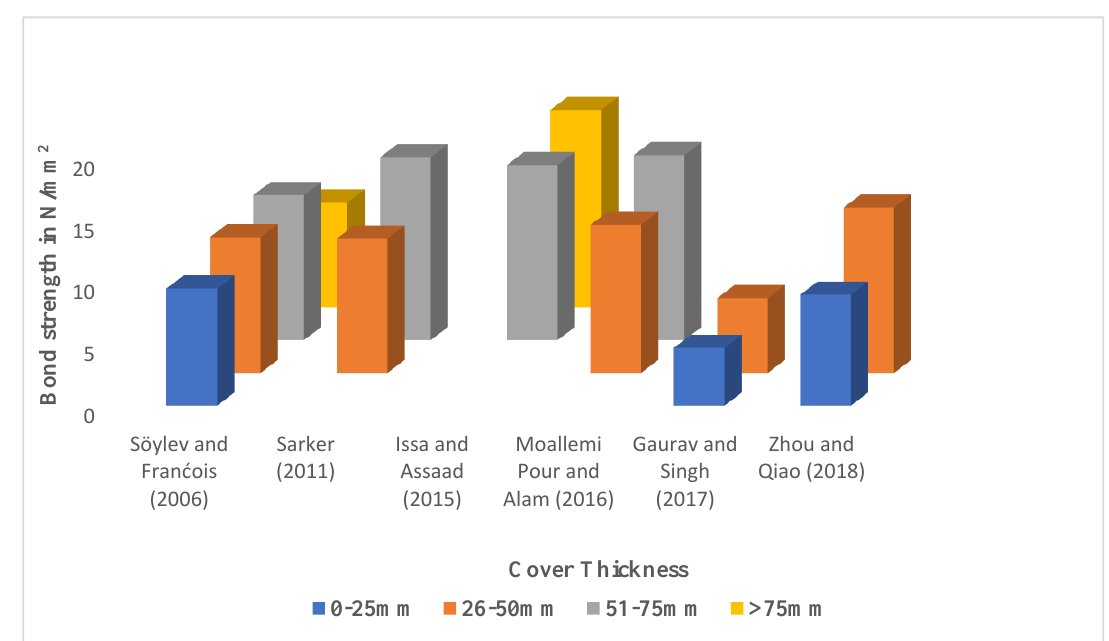
Figure 9. Chart representing bond strength attained at different cover thickness [20,36,48,62,137,144].